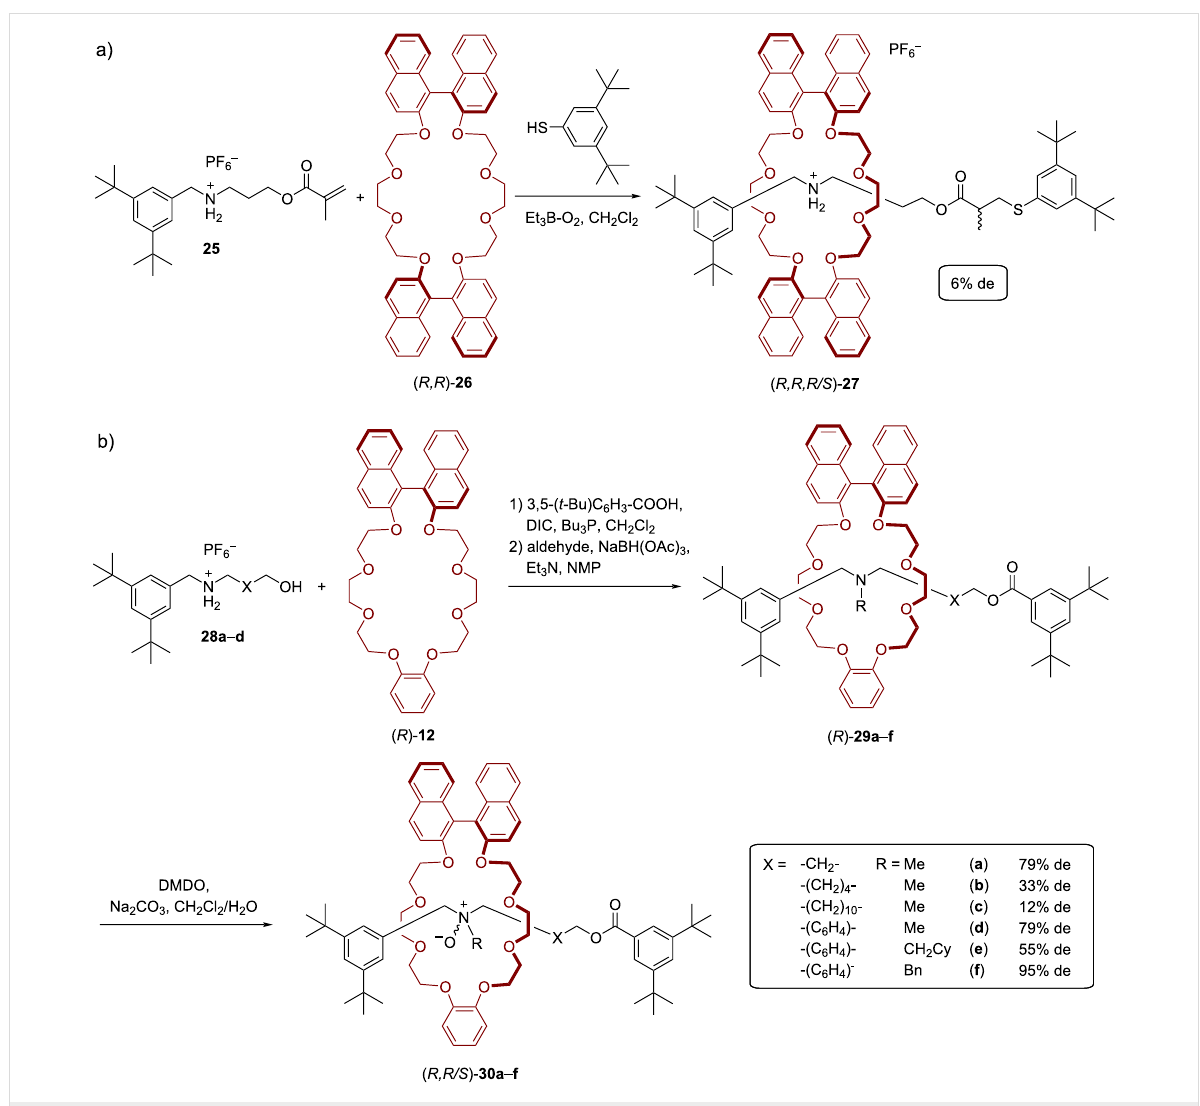
Figure 6: Synthesis of Takata´s rotaxanes featuring chiral centers on the axle: a) rotaxane ( R,R,R/S )- 27 obtained by thiol–ene addition and b) rotax- anes ( R,R/S )- 30a – f obtained by amine